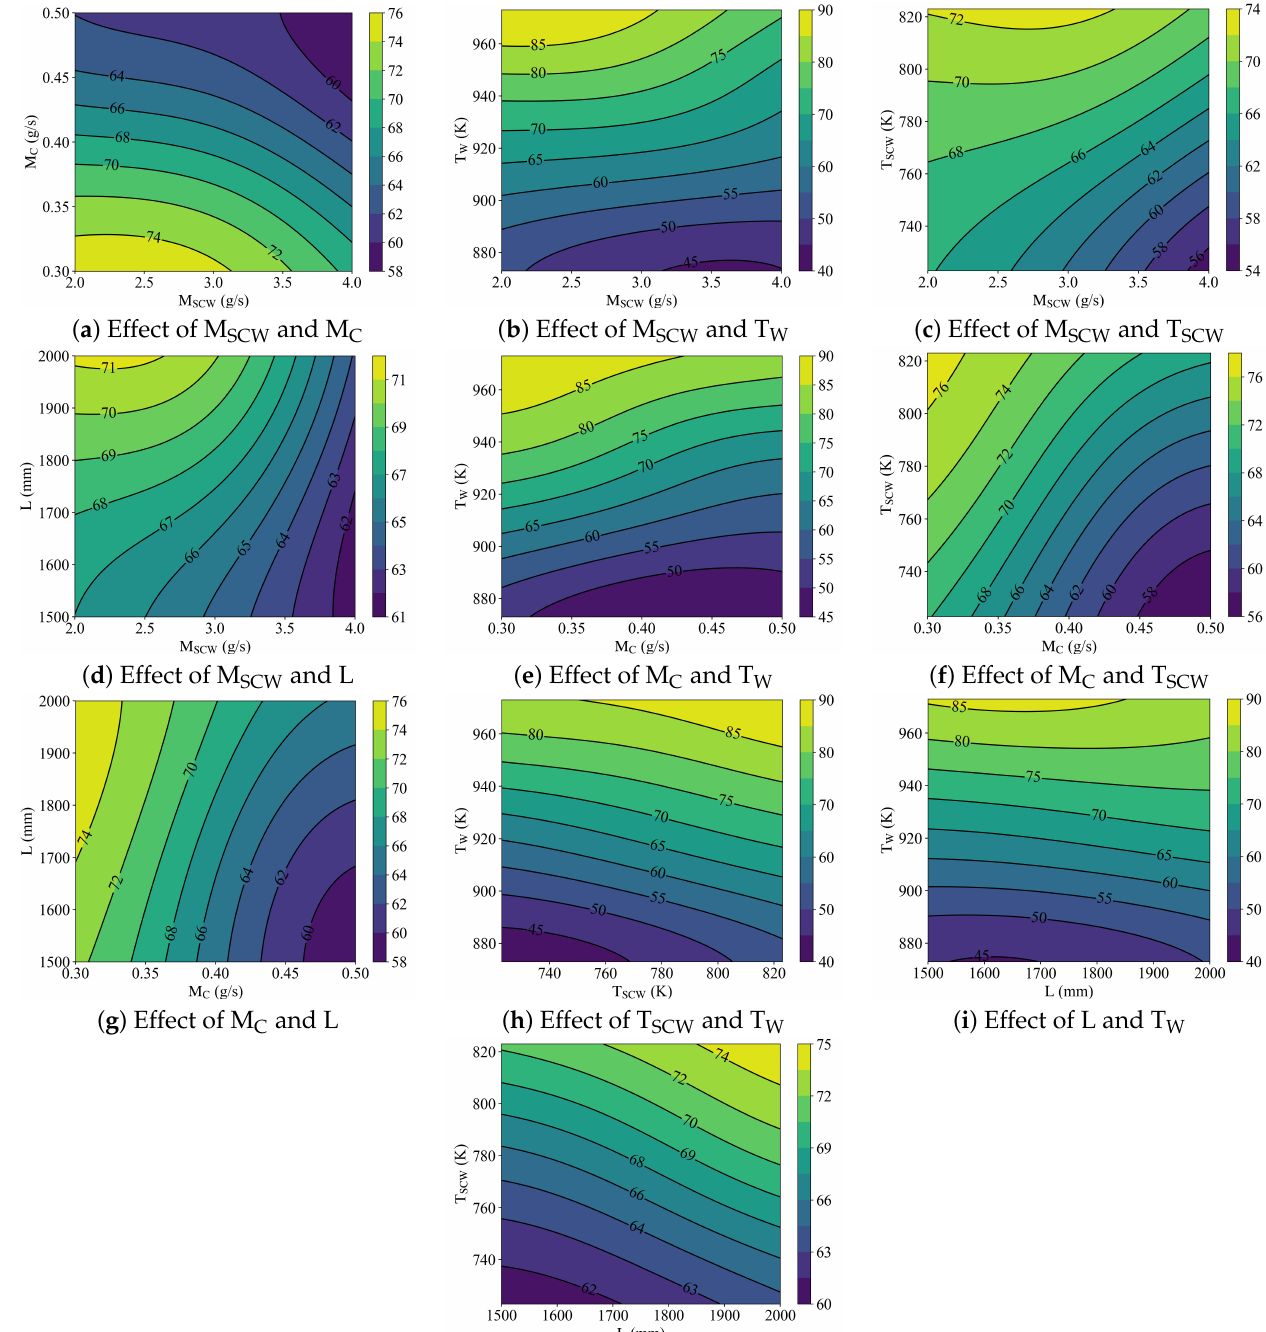
Figure 8. Two-dimensional contour plots of the coupled effect of parameters on the reactor’s